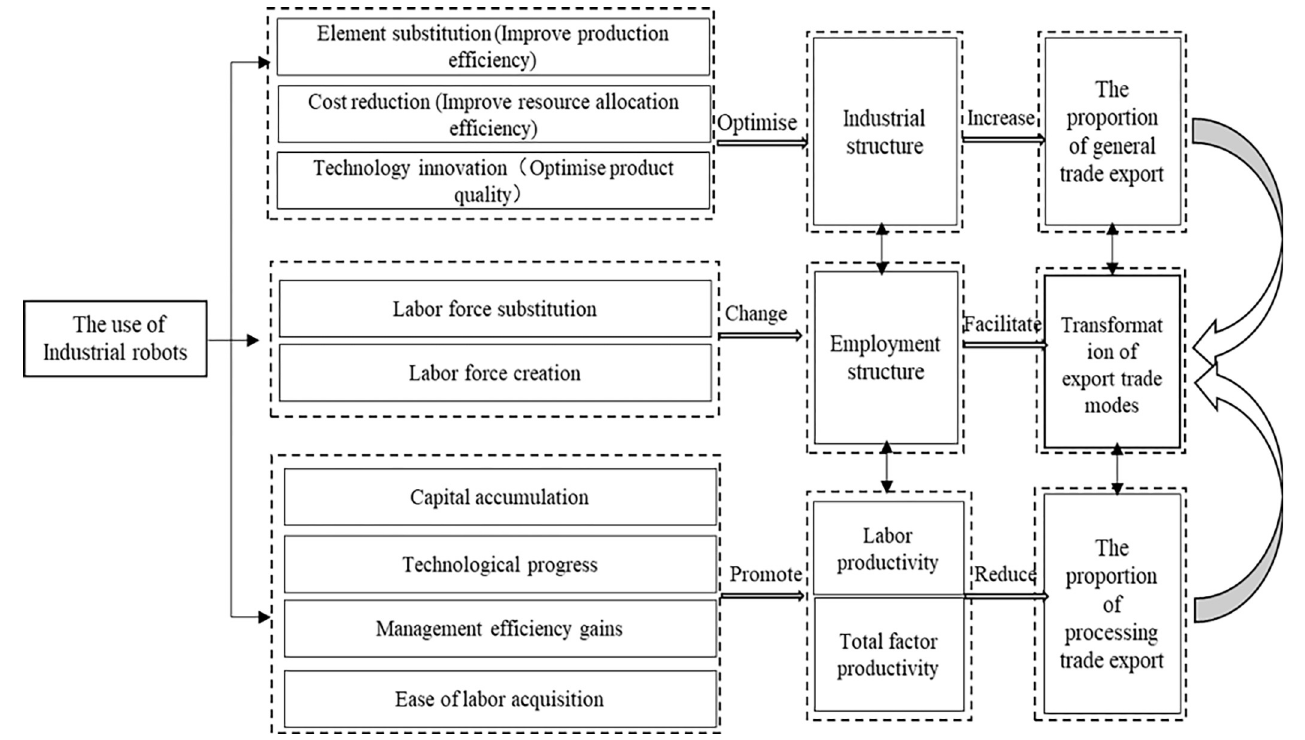
Fig 2. Mechanism’s diagram of the use of industrial robots promotes the transformation of trade patterns.